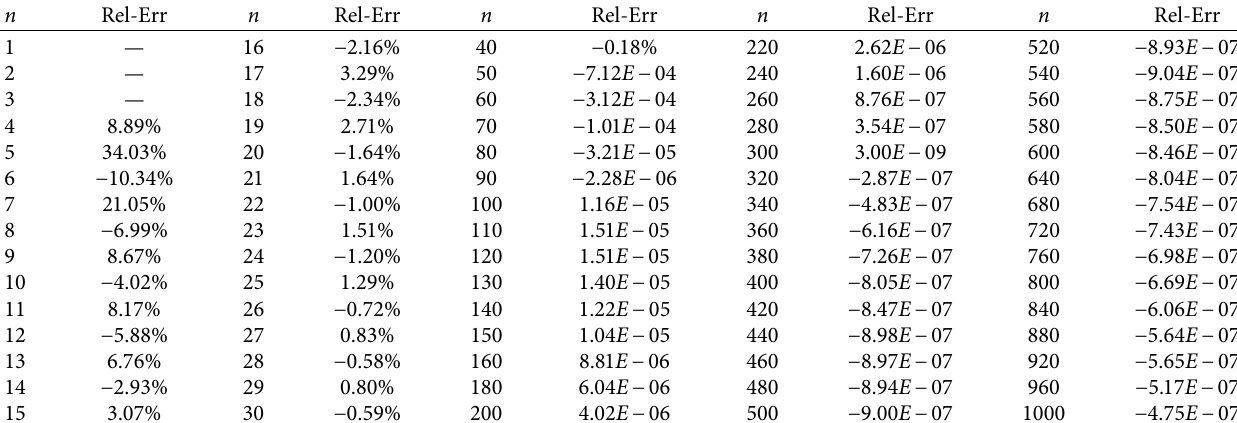
( n ) to h ( n ) when n ≤ 1000. ga